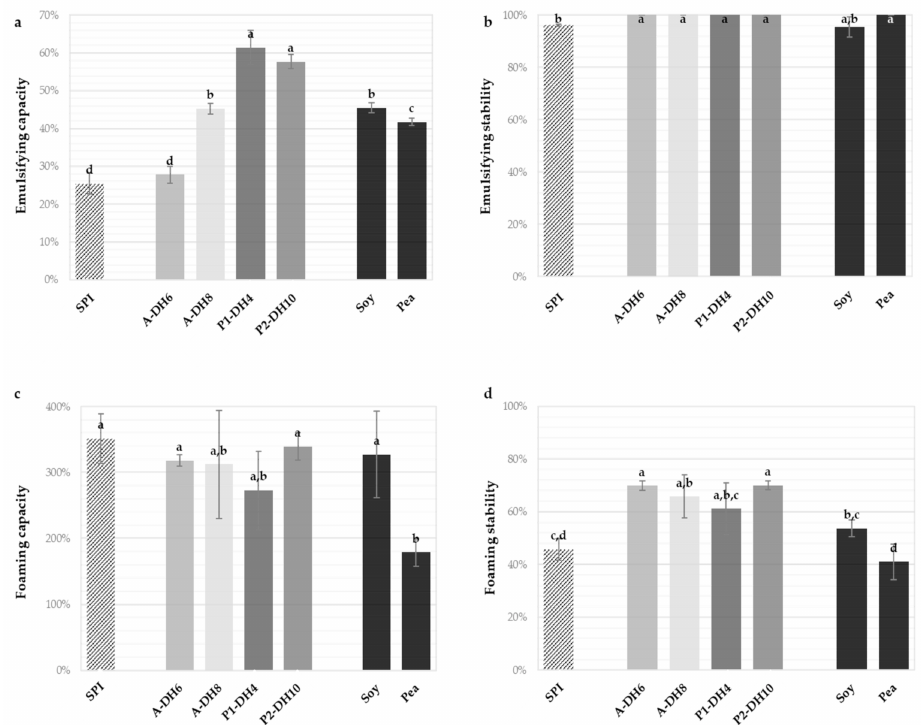
Figure 4. Emulsifying capacities ( a ), emulsifying stabilities ( b ), foaming capacities ( c ) and foaming stabilities after 120 min ( d ) of the initial sunflower protein isolate (SPI), the chosen hydrolysates and the commercial pea isolate and partially hydrolyzed soy isolate, measured at pH 7.0. Values are means ( n = 3) and the error bars are the standard deviations. Samples with a common letter are not different ( p >